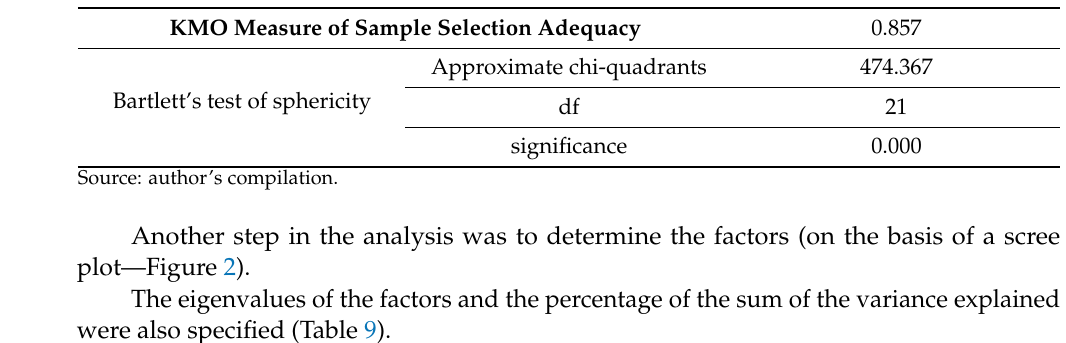
Table 8. Kaiser-Mayer-Olkin tests and Bartlett’s tests for the